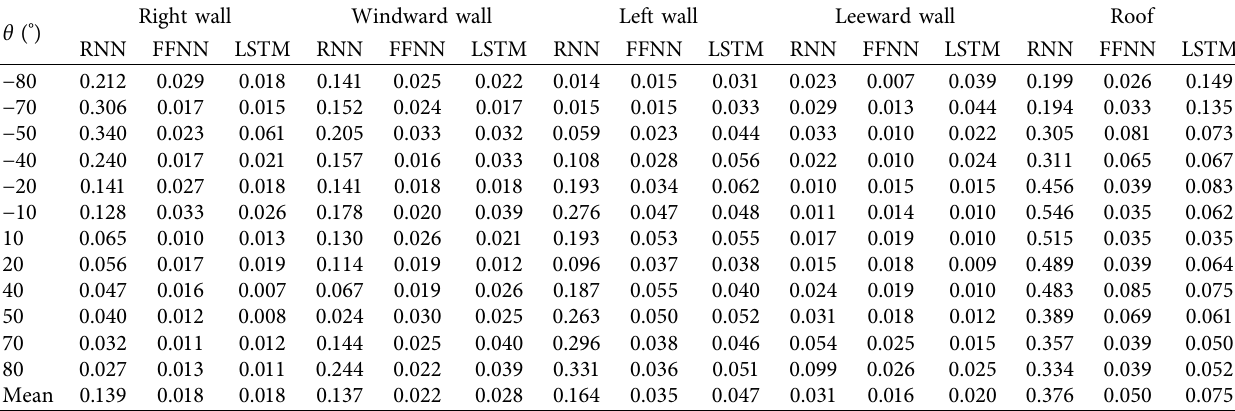
Table 5: Variation of MSE on the faces of the low-rise building for different wind direction by using the trained ANN models. Right wall Windward wall Left wall θ ( ° )